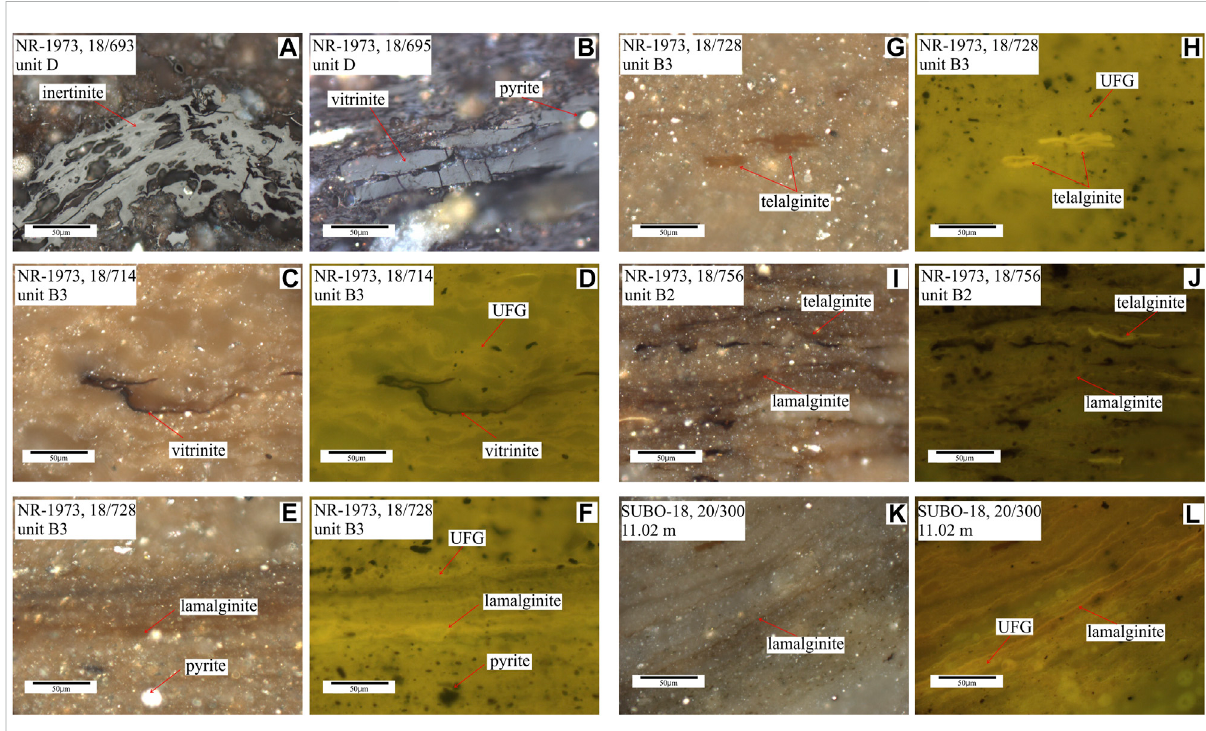
FIGURE 9 Maceral microphotographs of selected polished sections from the NR-1973 and SUBO-18. See Figure 2 for stratigraphic units. (A,B,C,E,G,I,K) are taken under white incident light; (D,F,H,J,L) show the fl uorescence mode excited by